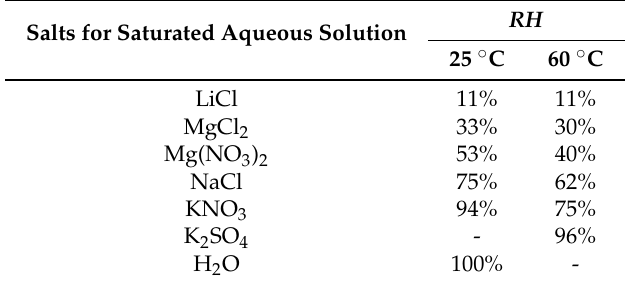
Table 1. Summary of saturated salt solutions used for the samples conditioning at different relative humidity ( RH